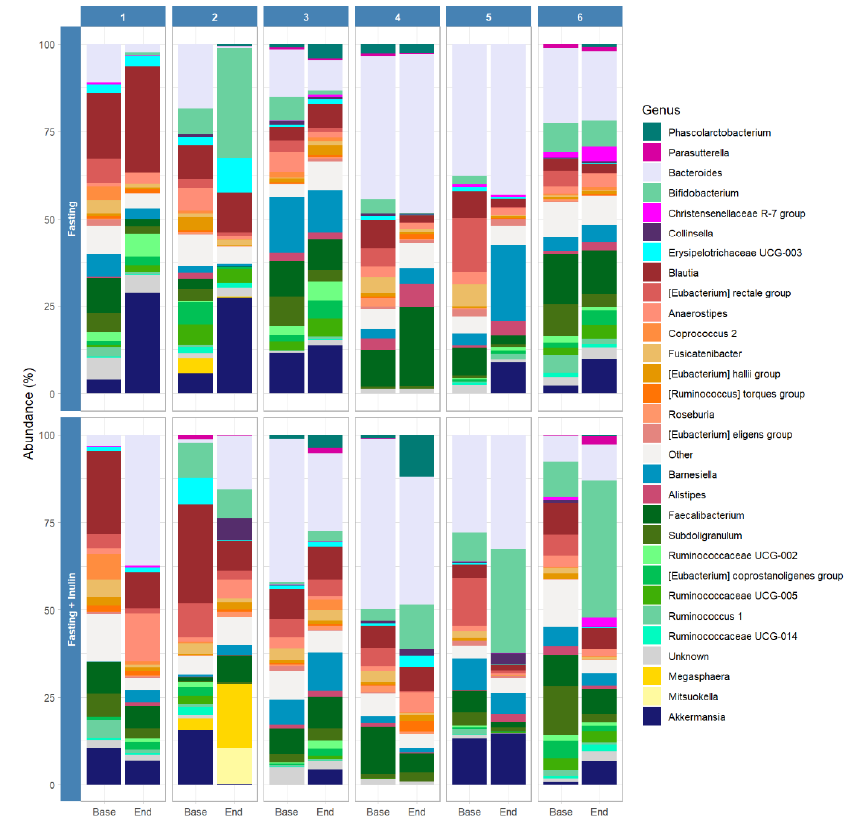
Figure 3. Relative abundance of the most abundant genera at the individual level before and after fasting interventions and inulin consumption. Genera from the same family are grouped next to each other by decreasing levels of abundance and colored with a similar shade of color.